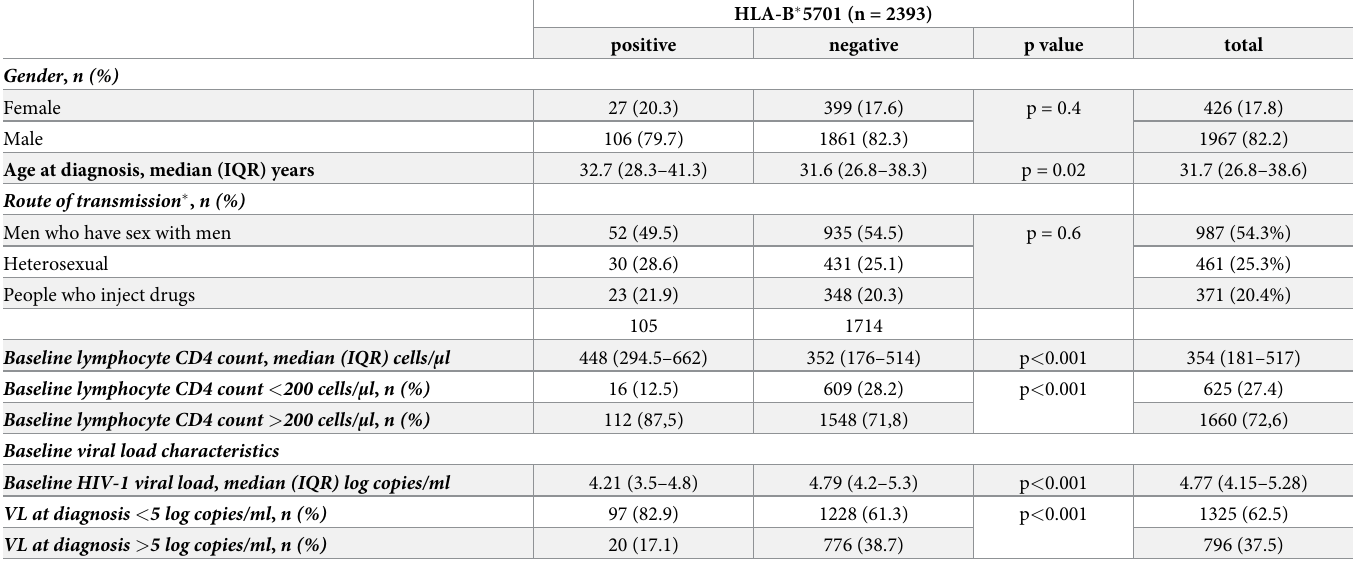
Table 1. Baseline characteristics in examined